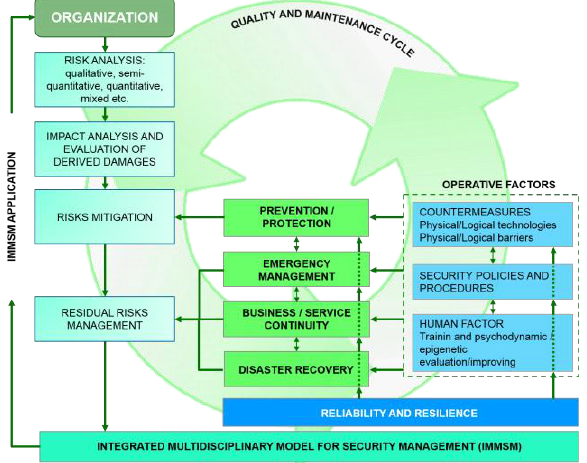
Figure 14. Scheme of the integrated multidisciplinary model for security and safety management